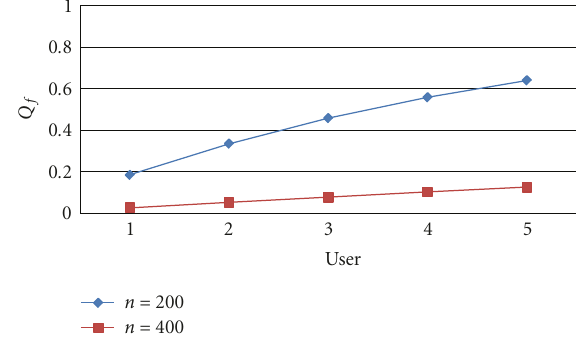
Figure 7: Performance of probability of false alarm using OR-rule cooperative sensing under various SNR conditions.